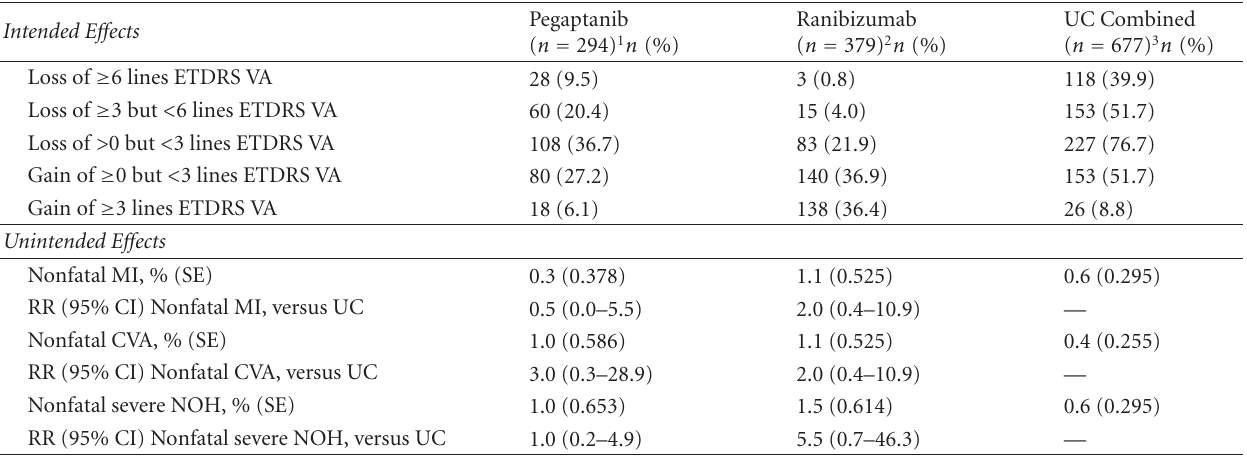
Table 1: Model inputs, intended and unintended e ff